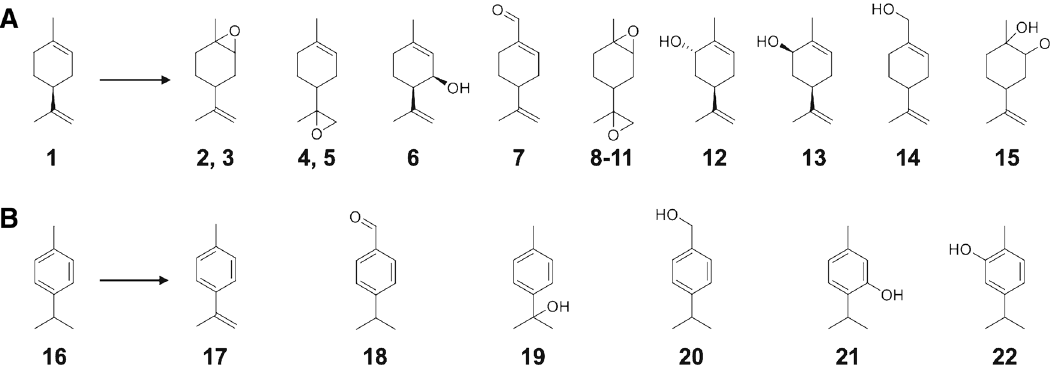
Figure 1. Various oxidized compounds detected from reaction products converted by wild-type CYP102A1. ( A ) ( S )-(−)-Limonene ( 1 ) was converted to 14 oxidized compounds, i.e., limonene-1,2-epoxide and its isomer ( 2 , 3 ), limonene-8,9-epoxide and its isomer ( 4 , 5 ), cis -isopiperitenol ( 6 ), (−)-perillaldehyde ( 7 ), limonene diepoxide and its isomers ( 8 – 11 ), trans -carveol ( 12 ), cis -carveol ( 13 ), perillyl alcohol ( 14 ) and limonene-1,2-